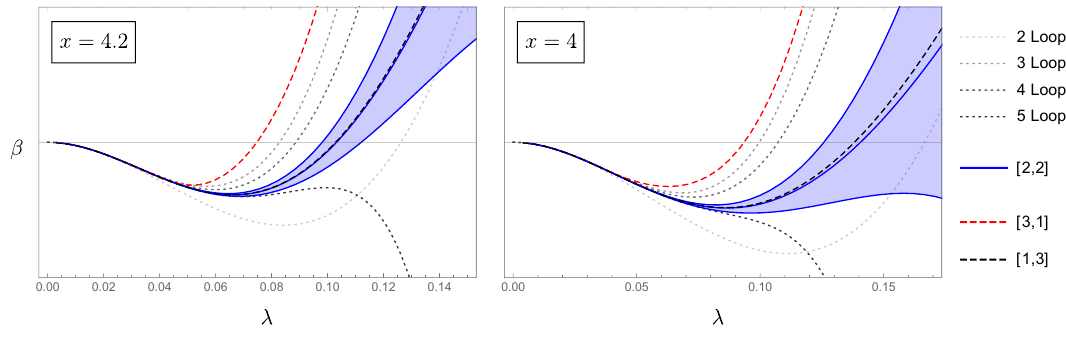
Figure 4 . (cid:12) -function as a function of the coupling (cid:21) in the Veneziano limit. Dotted grey lines denote results in perturbation theory, dashed lines denote the central values of the Borel resummations using [3 = 1] ad [1 = 3] Pad(cid:19)e approximants as indicated in the legend. The shaded area corresponds to the error associated to the [2 = 2] approximant and its central value is given by the continuous blu line in the middle. In both panels the error band corresponds to c np =